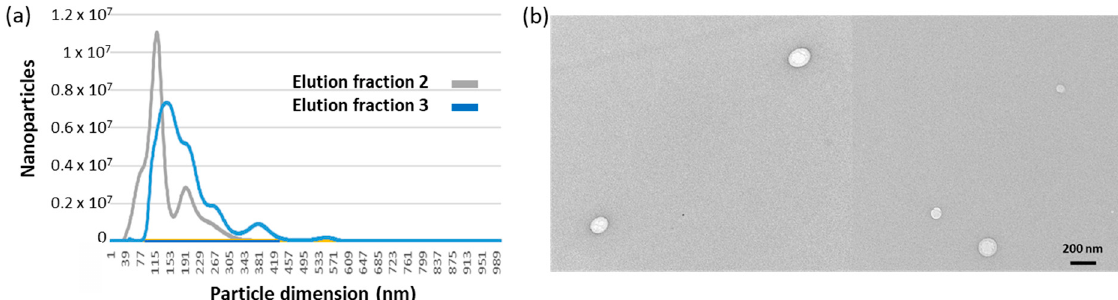
Figure 3. EV size distribution in samples corresponding to different elution fractions . ( a ) Nanosight profiles of immunopurified EVs. EVs bound to the monolith disc functionalized with anti ‐ CD63 nanobodies were eluted by lowering the buffer to pH 2.5. The fraction corresponding to the void volume was removed, and two fractions, each roughly corresponding to the column volume, were collected, and the pH of their buffer was neutralized. ( b ) TEM images of immunopurified EVs.